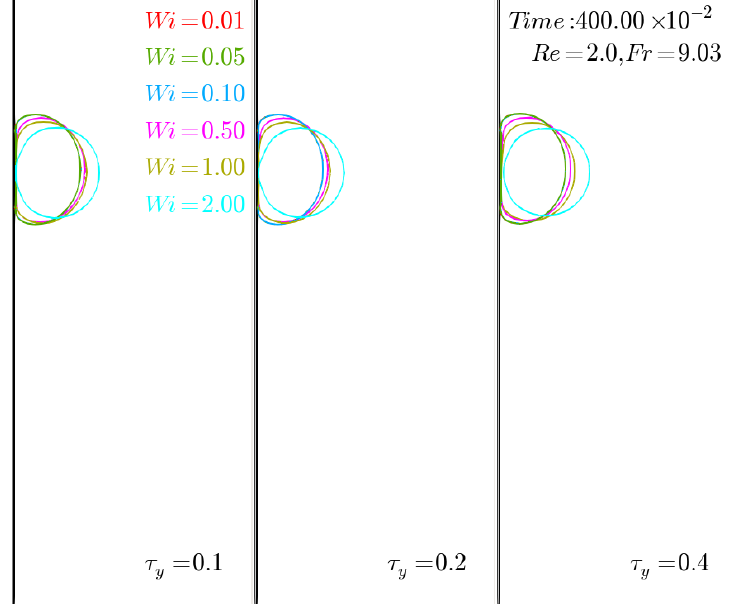
Figure 13. Collision of drops on a vertical wall for fixed values of the Reynolds, Re = 8, and plastic numbers, τ y = 0.4 and the following values of the Weissenberg number, Wi = { 0.01;0.1;0.5;1 } . ( left column ) Fr = 4.52; ( right column ) Fr = 1.13. Dimensionless time, t =